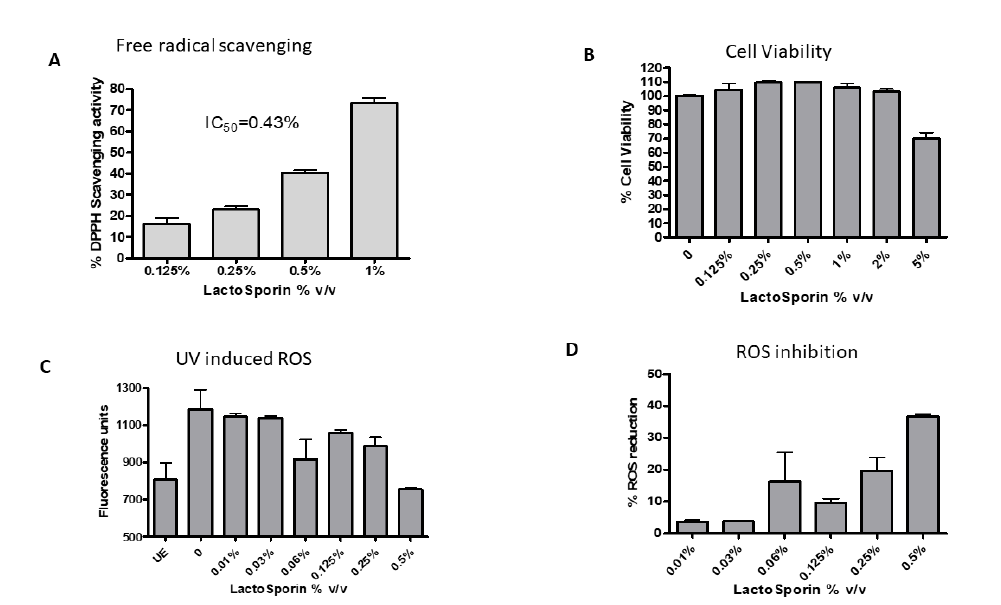
Figure 1. Effect of various concentrations of LactoSporin on ( A ) 1,1-diphenyl-2-picrylhydrazyl (DPPH) free radical scavenging activity and ( B ) Cell viability at different concentrations of LactoSporin ( C ) Intracellular reactive oxygen species (ROS) induced by UV-A, ( D ) ROS scavenging activity. Data are represented as Mean ±SD, n = 3. UE: Unexposed cells.